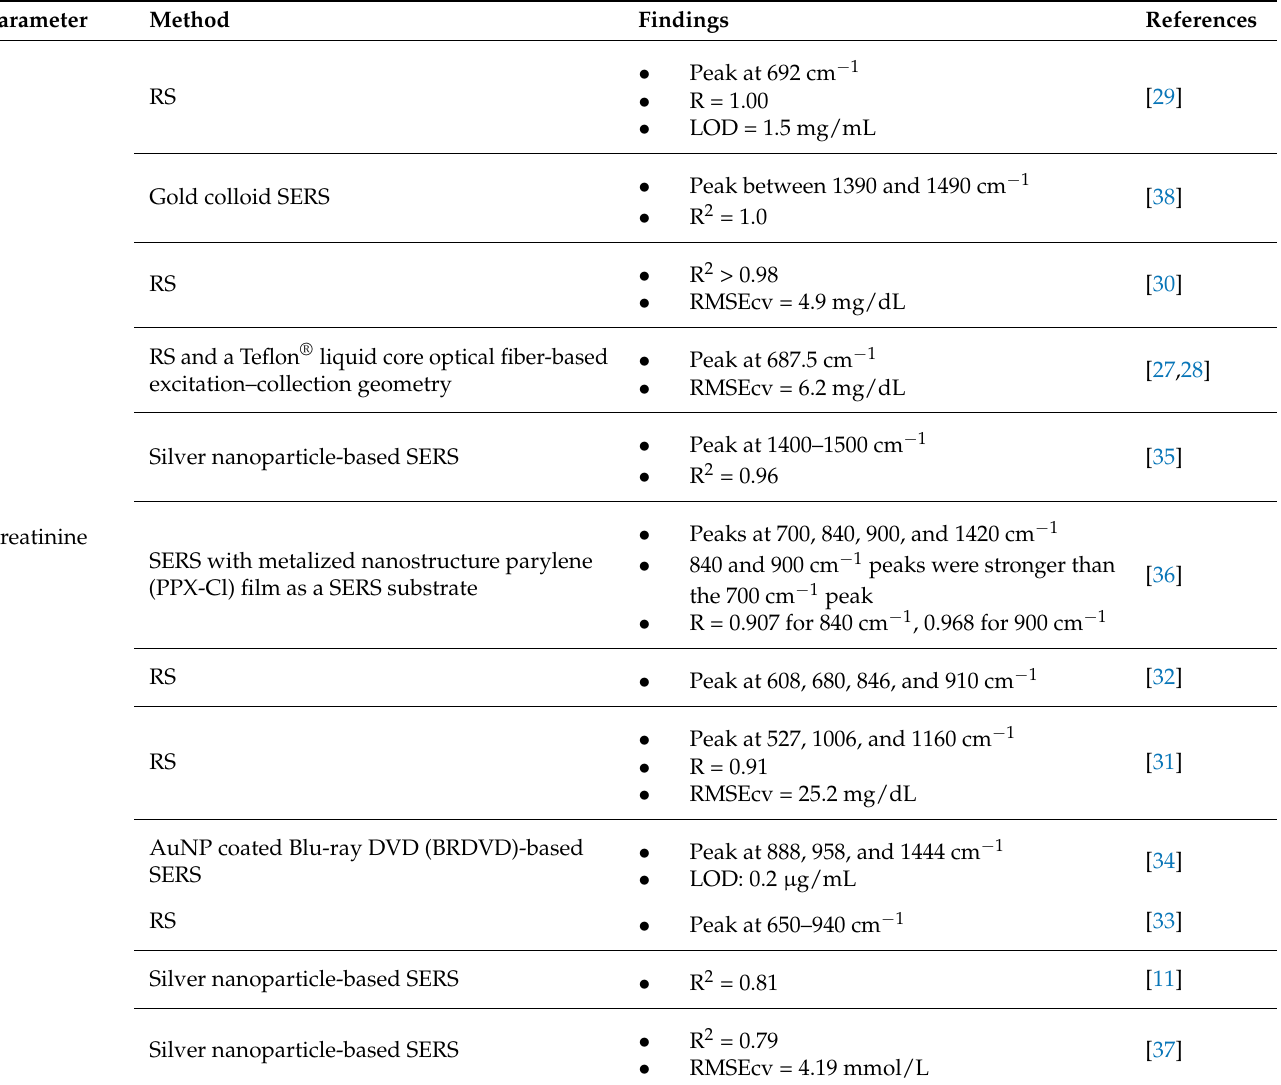
Table 1. Raman spectroscopy (RS) and surface-enhanced Raman spectroscopy (SERS) studies for measuring creatinine, urea, glucose, protein/albumin, and blood in urine.